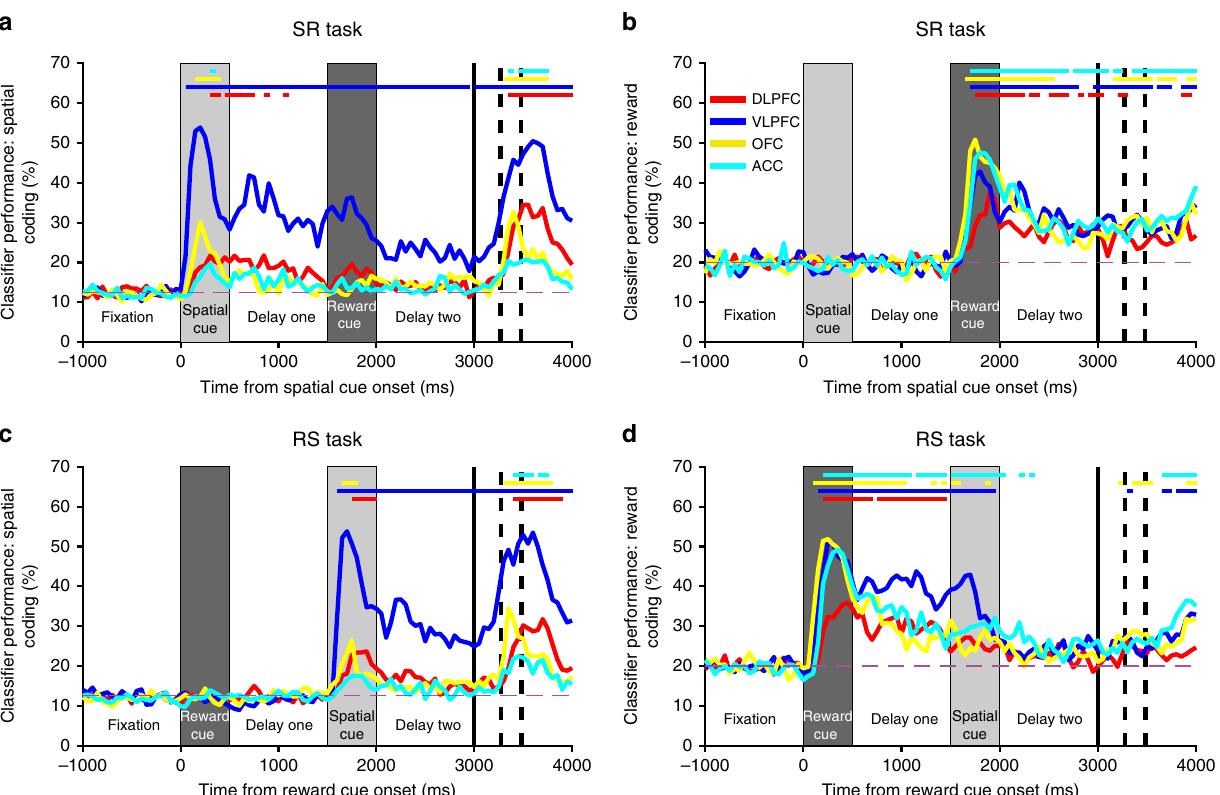
Fig. 2 Ventrolateral prefrontal neurons maintain information for both spatial and reward stimuli during delay epochs. The mean performance of classi fi ers (1000 permutations, Methods) trained to decode each task feature (spatial location, a , c ; reward level, b , d ) are plotted for each brain area and trial type (SR-task, a , b ; RS-task, c , d ). Ventrolateral prefrontal cortex (VLPFC) is the only region to strongly code information about space and reward across the trial. Notably, the VLPFC activity primarily encodes the factor most recently presented. When the reward cue is shown fi rst (RS-task, c , d ), a representation of reward size is maintained throughout delay-one, but falls away when the spatial cue is presented. More surprisingly, a similar weakening of spatial coding is also observed on the SR-task ( a ), even though this analysis is restricted to trials where the subject remembered the correct spatial location. The VLPFC population strongly encodes and maintains a representation of the remembered spatial location, but this is substantially weakened by the offset of the reward cue. The fi rst solid vertical line signi fi es when subjects were cued to respond. The fi rst and second dashed vertical lines represent the average timing of the subjects ’ saccade and the onset of reward, respectively. Solid coloured horizontal lines represent signi fi cant encoding for the corresponding brain region (2.5th percentile of distribution > chance level, p < 0.05, Methods). The dashed magenta line represents chance level classi fi er